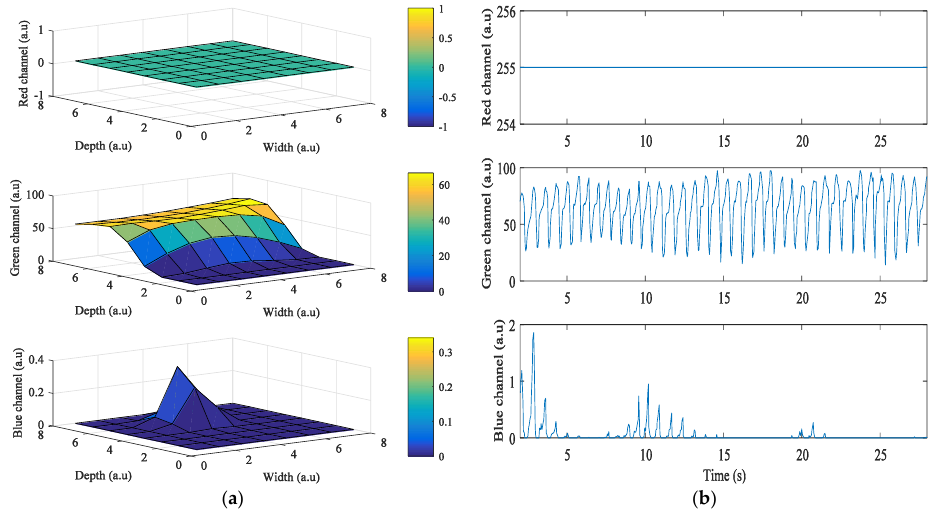
Figure 4. Example of quality analysis of PPG signals obtained from a subject using the Galaxy Note 3: ( a ) intensity change distribution; ( b ) intensity of PPG signal.